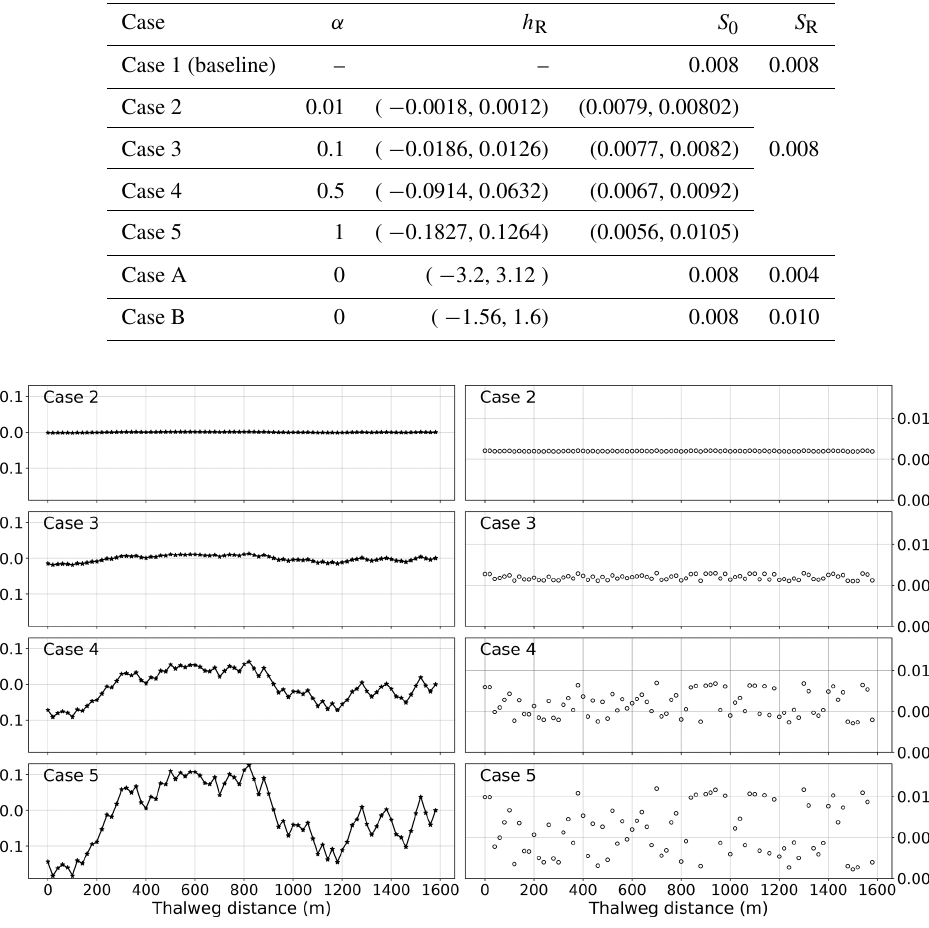
Figure 8. Channel bottom offset ( h R ) and physical thalweg slope ( S 0 ) for synthetic test cases 2–5 that are random perturbations of the baseline smooth S 0 = 0 . 008 of Case